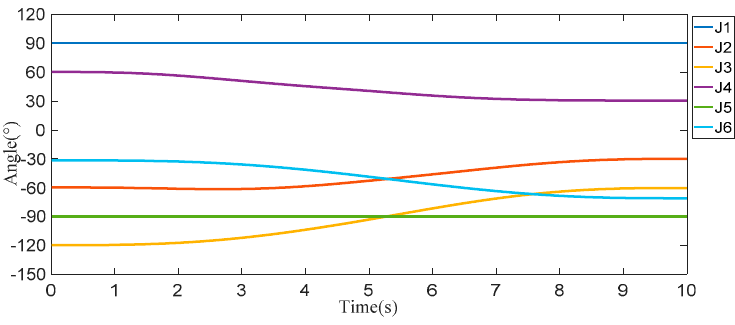
Figure 15. Curves of the low-contact impact trajectory: ( a ) Displacement, ( b ) Velocity, and ( c ) Acceleration.